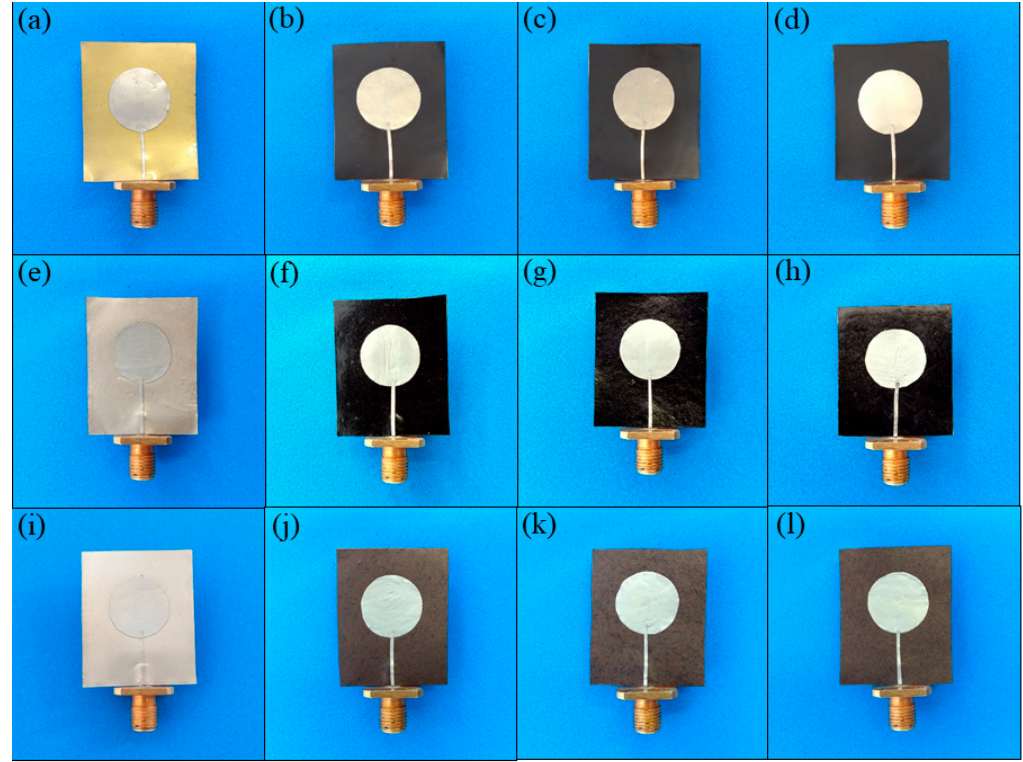
Figure 8. Microstrip antennas developed with substrates based on Ch ( a – d , 0–80% of SPIONs, respectively), Col ( e – h , 0–80%) and BC ( i – l , 0–80%).